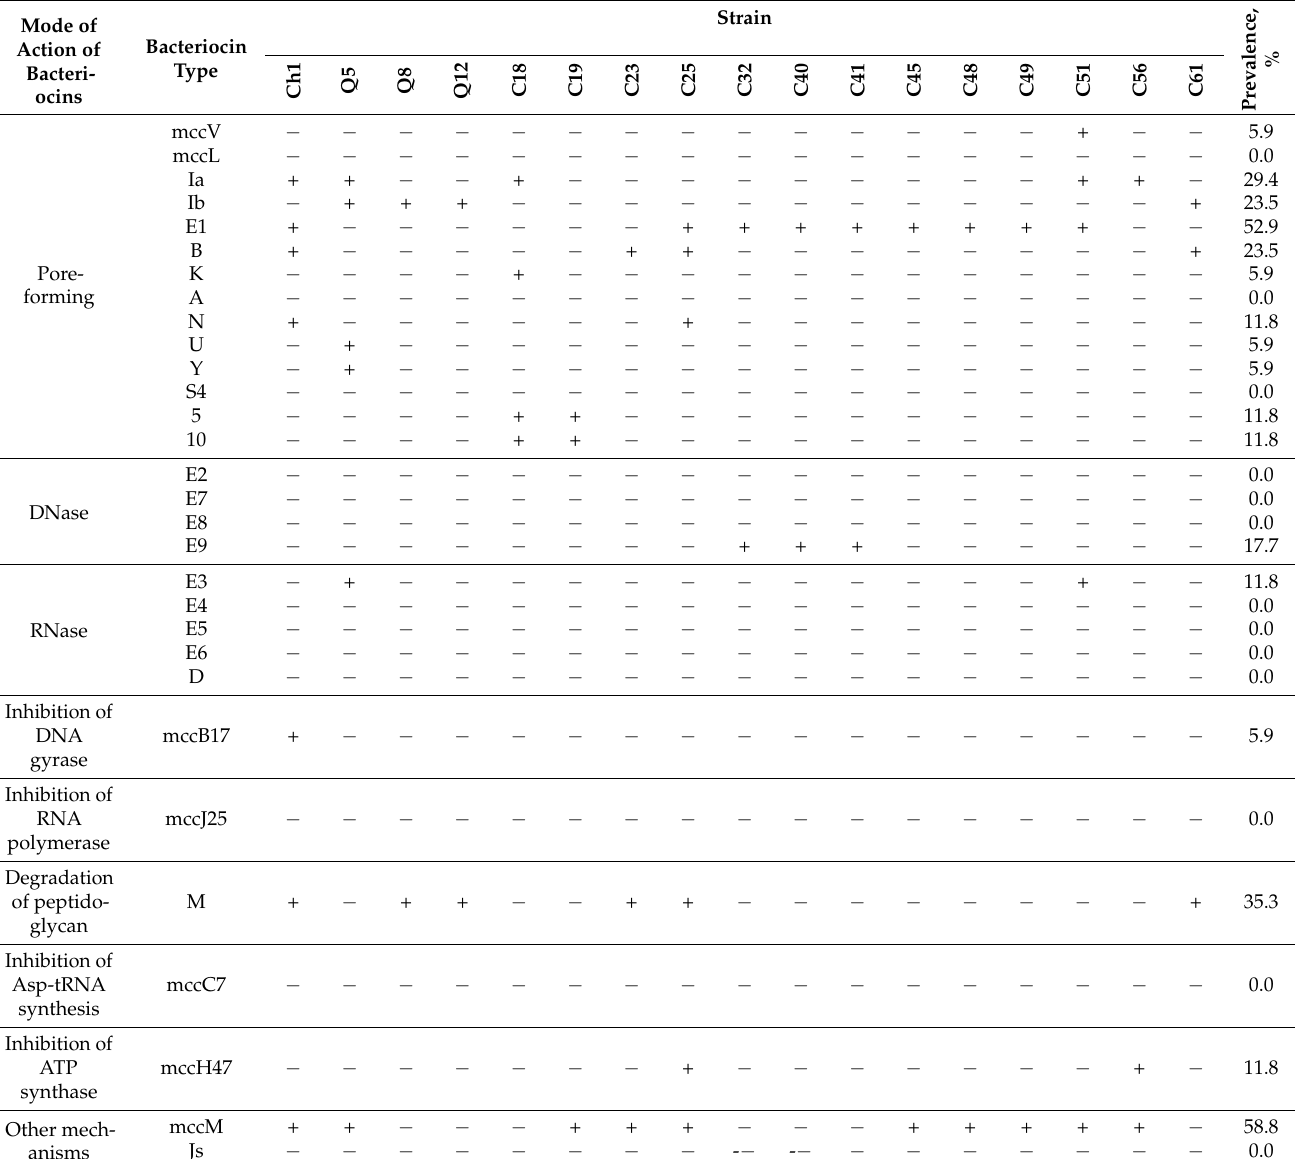
Table 3. Distribution and prevalence of bacteriocin genes among E. coli strains obtained from healthy